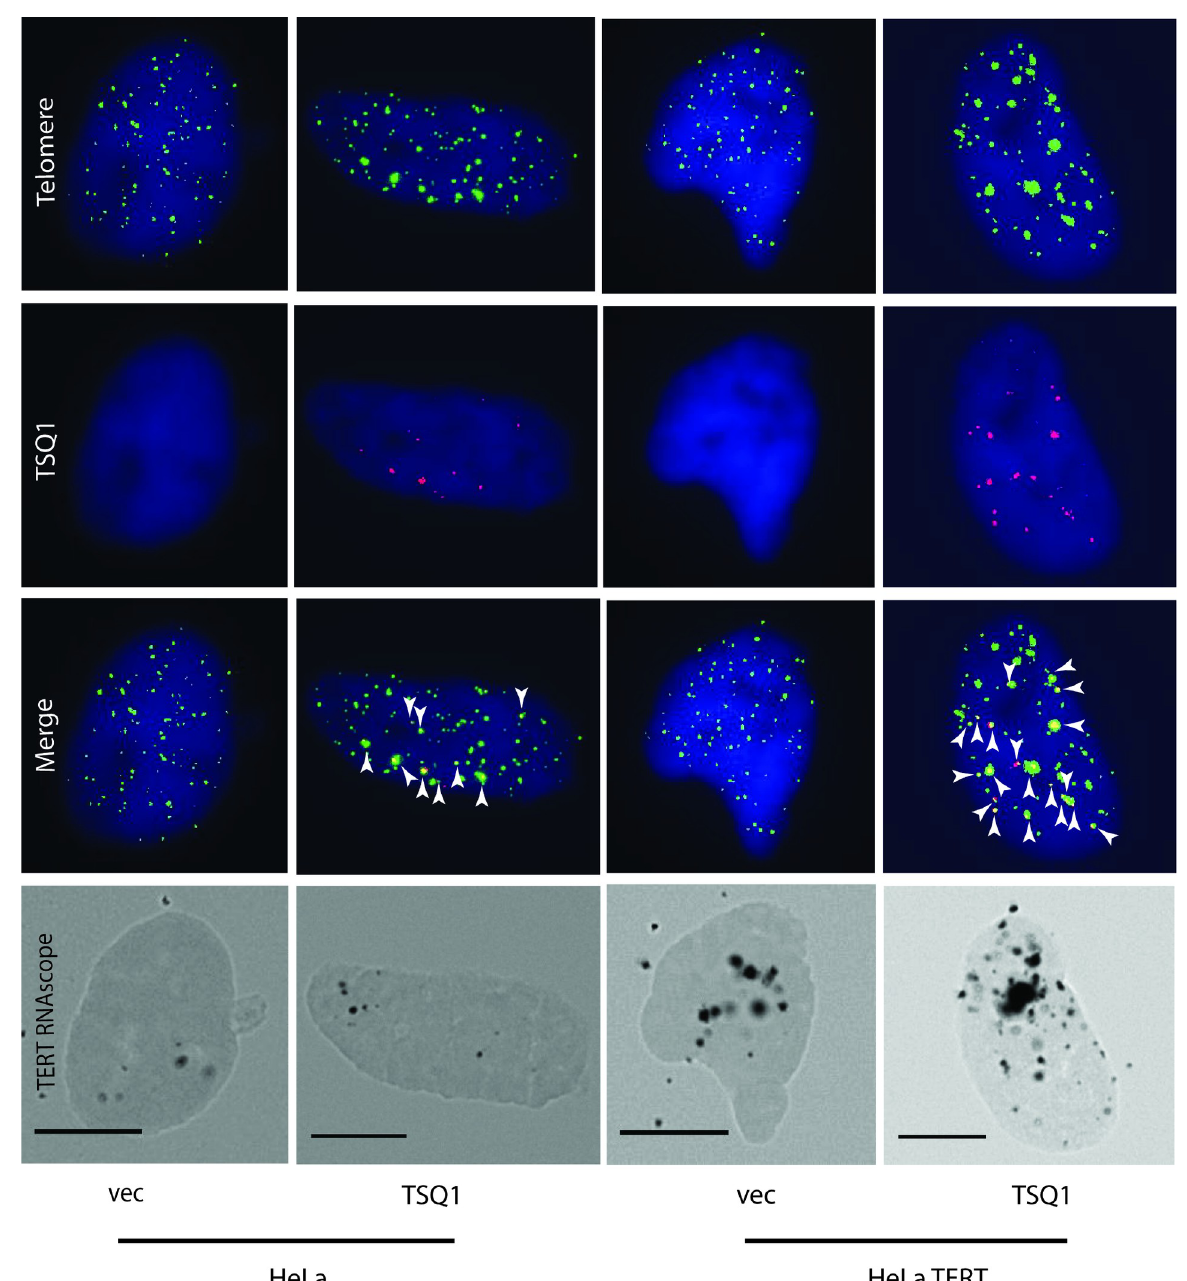
Fig 3. Combined RNAscope/PNA-FISH can be used to detect TERT expression and telomere elongation in single cells. Cells were assayed 7 days post-TSQ1 or vector infection. They were imaged via fluorescence for wild-type telomere (green) and TSQ1 (red) signal and then bright-field for the brown TERT DAB reaction product. TSQ1 spots co-localizing at telomeres are marked with arrows. Representative images are shown and scale bars denote 10 μ M.